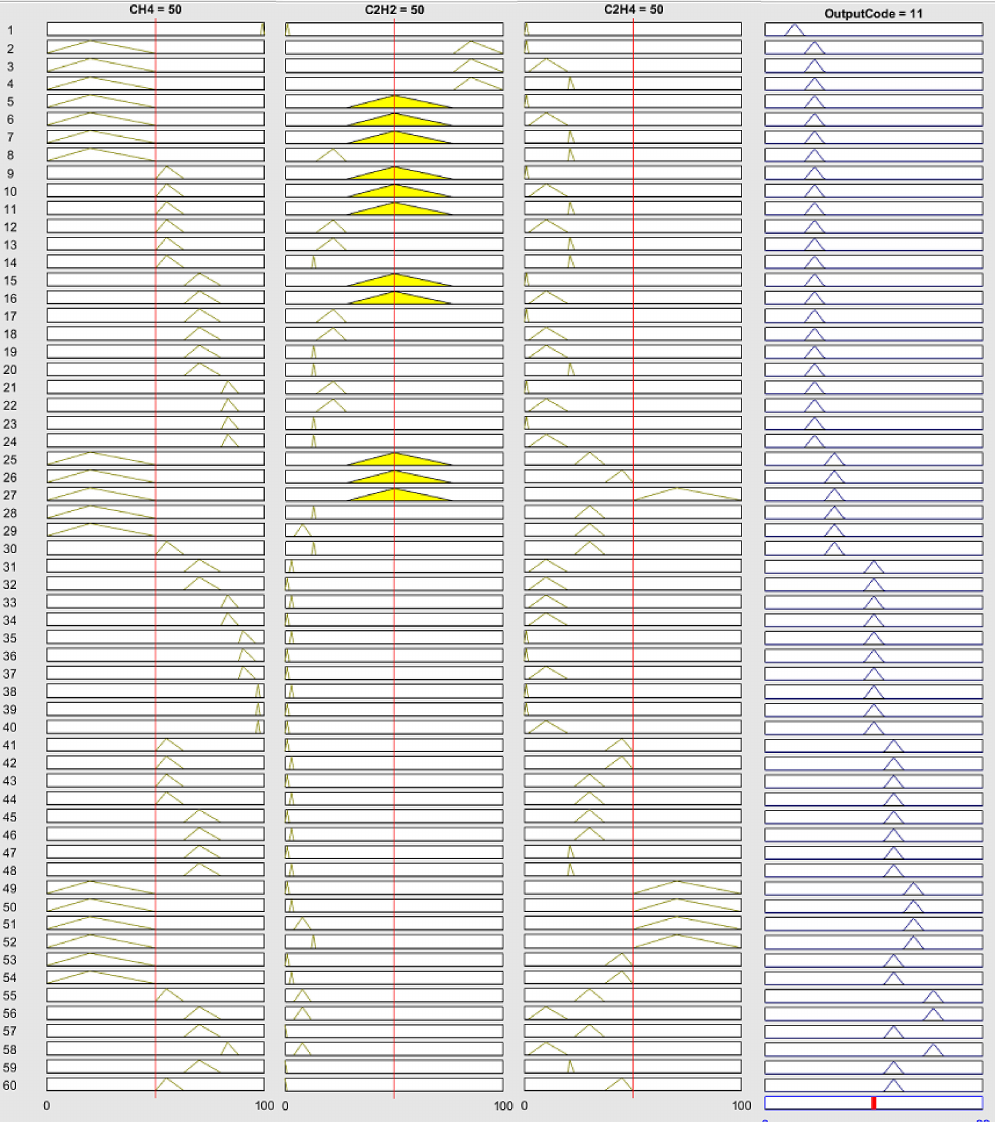
Figure 7. Fuzzy rules for fault identification by using the Duval triangle